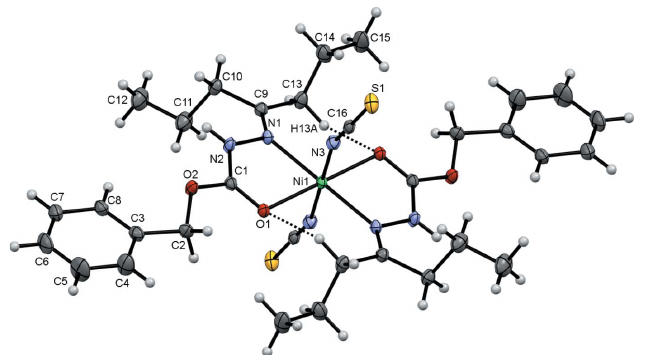
Figure 1 The molecular structure of 1 showing the atom numbering with ellipsoids drawn at the 50% probability level. Labelled atoms are related to unlabelled atoms by the symmetry operation (cid:5) x + 1, (cid:5) y , (cid:5) z + 2. Intramolecular hydrogen bonds are shown as dashed black lines.